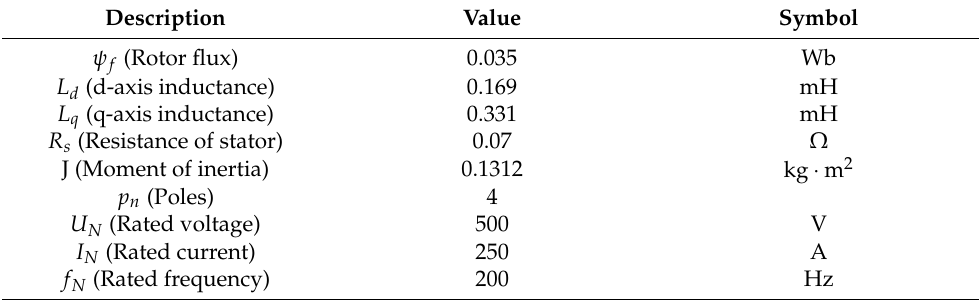
Table 1. The Toyota Prius Hybrid vehicles’ IPMSM